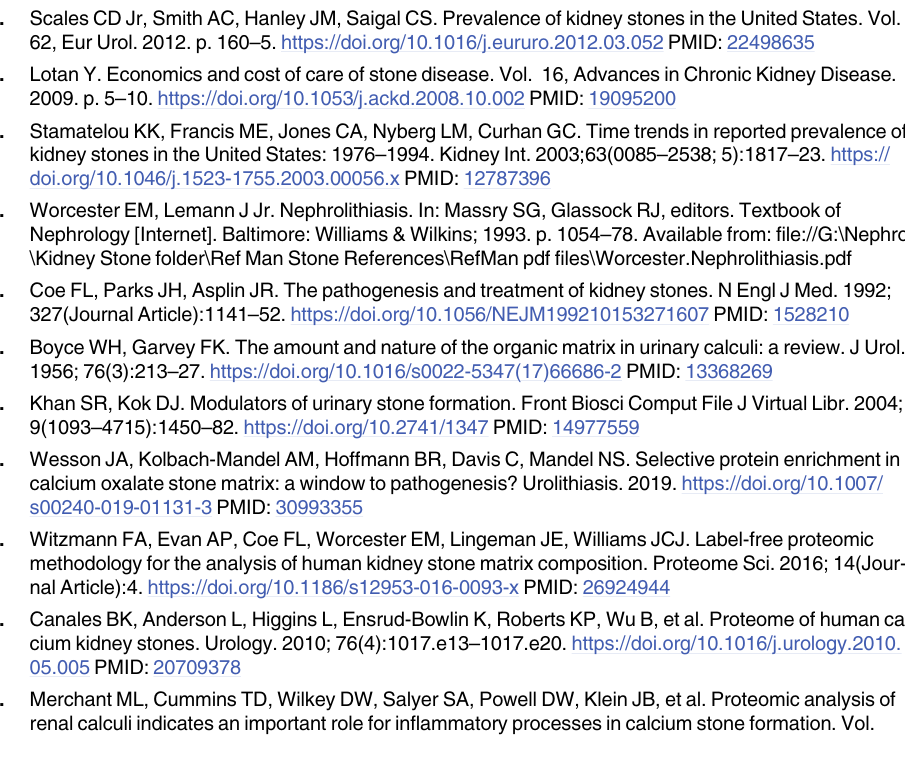
S3 Table. Truncated matrix phase preferring protein list. The MPP list in S1 Table was trun- cated by removing the 15 highly charged proteins (8 anionic ones with charge < - 5% and 7 cationic ones with charge > + 5%), and the truncated list is presented together with the UPP list from S2 Table. Only the protein abbreviations, total charge percentages, and net charge percentages are included in this